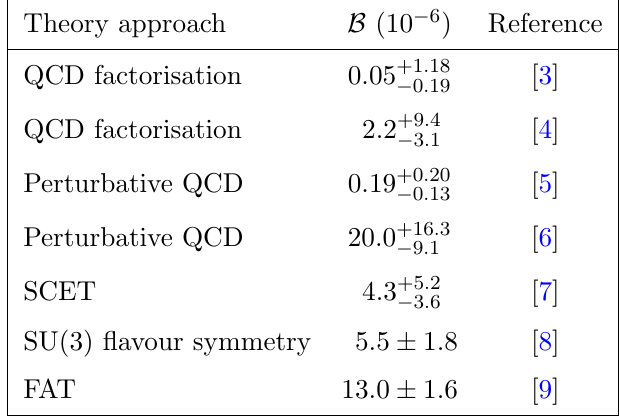
(cid:17) 0 (cid:30) branching fraction. s !